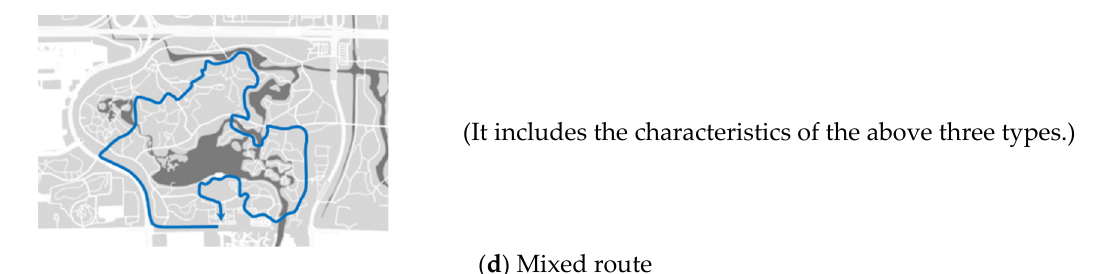
Figure 2. Four routes summarized for residents while they engage in physical activities in the Olympic Forest Park.